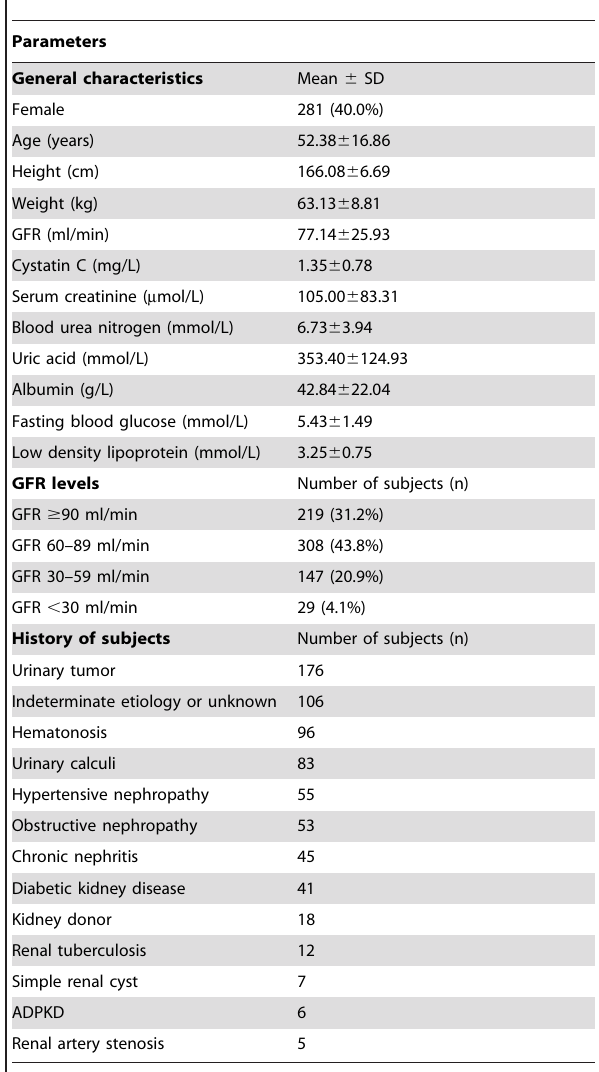
Table 3. Detailed characteristics of 703 Chinese